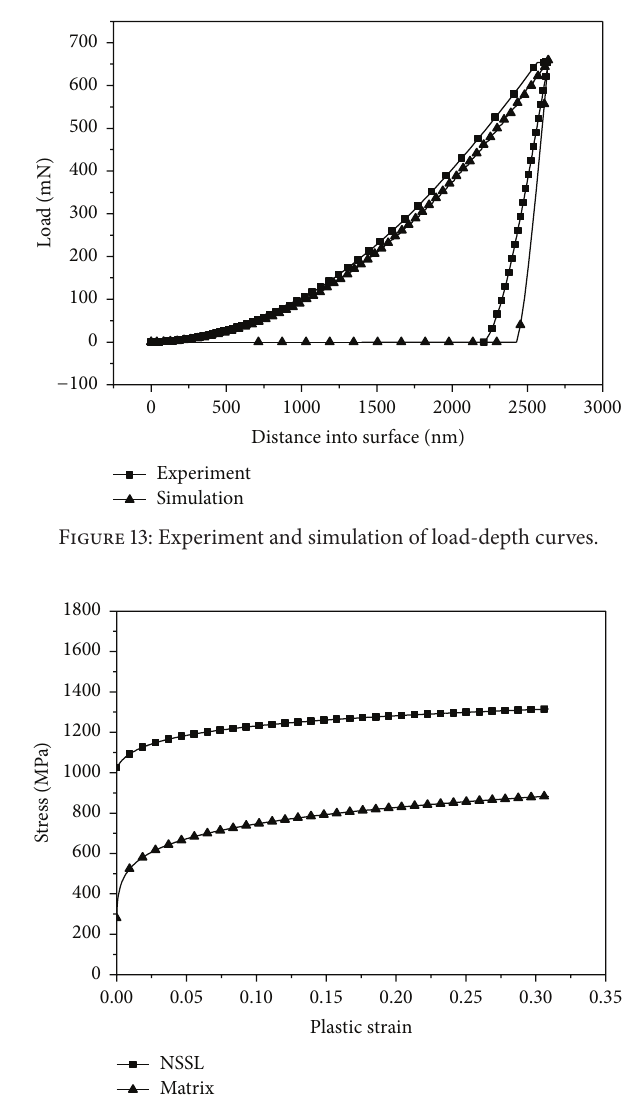
Figure 14: Stress-plastic strain curves of the NSSL and of the